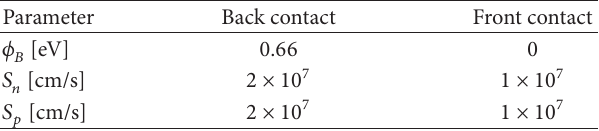
Table 3: Contact parameters applied to the simulations.